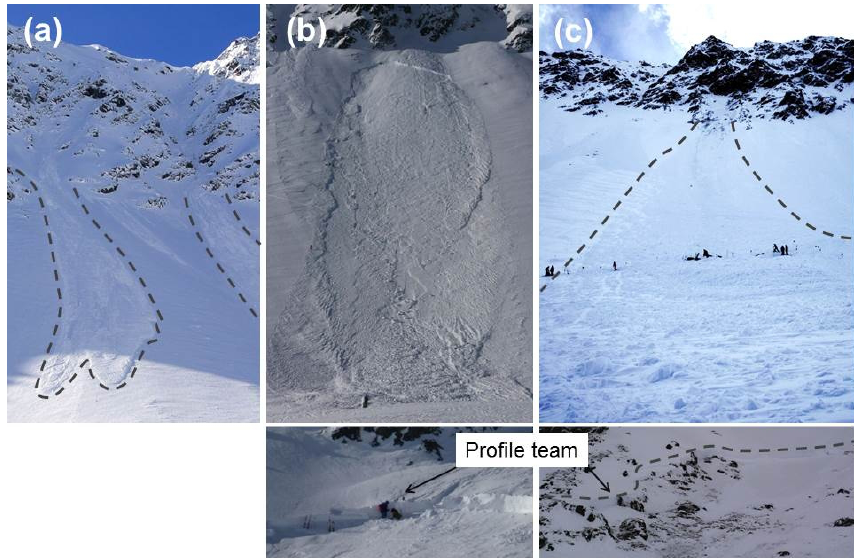
Figure 1. Avalanches at the Flüelapass field site released by artificial triggering of the cornices on the ridge. Avalanche #1a and #1b (a) were released on 23 January 2013, #2 (b) on 5 February 2013 and #3 (c) on 31 January 2014. Note the significant secondary release and entrainment of deeper layers below the rock face for (b) avalanche #2 and (c) avalanche